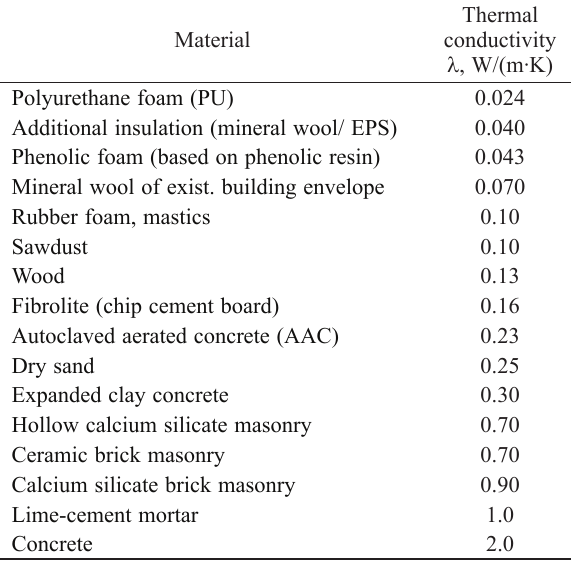
Lime-cement mortar 1.0